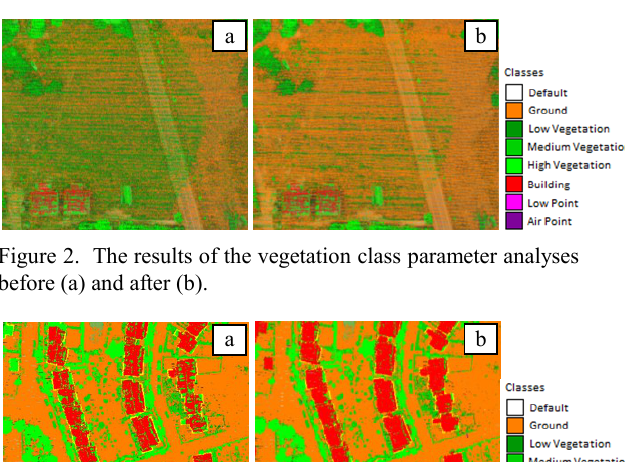
Figure 1. Workflow of the proposed automatic point based classification strategy with Approach 1 and Approach 2.